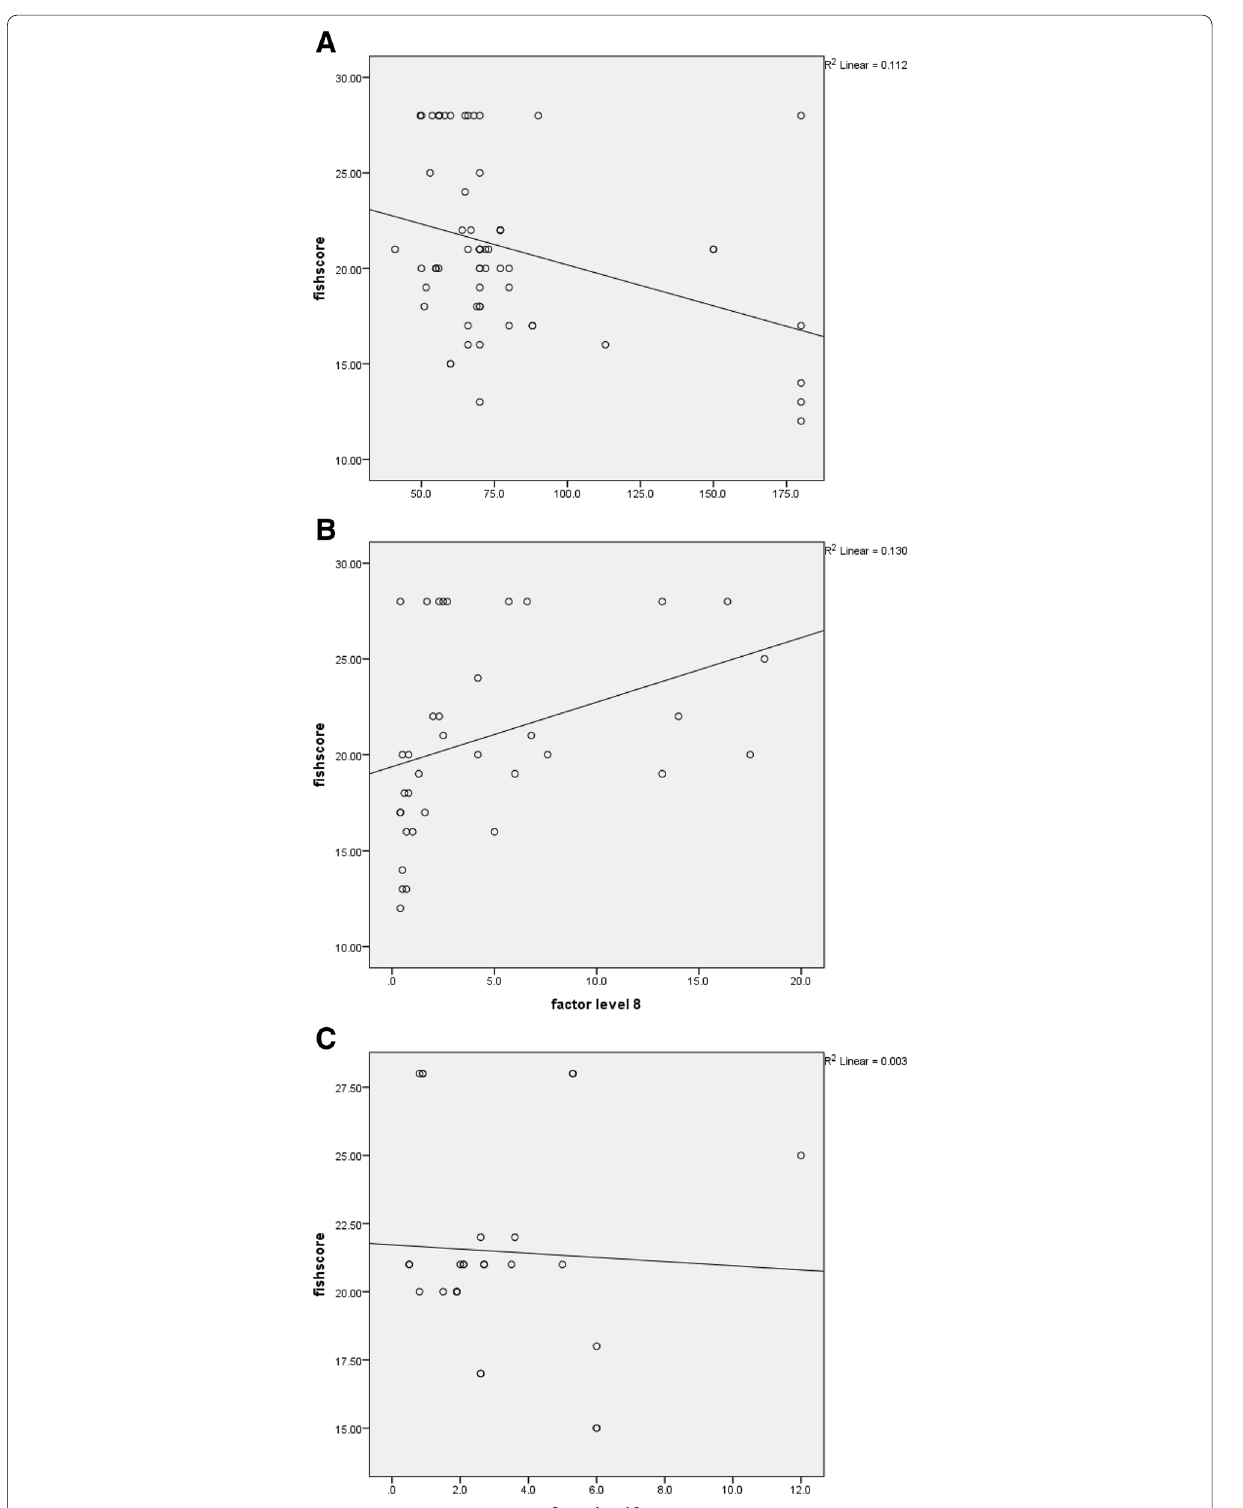
Fig. 7 A Correlation between APTT and total FISH score. B Correlation between factor level 8 and total FISH score. C Correlation between factor level 9 and total FISH